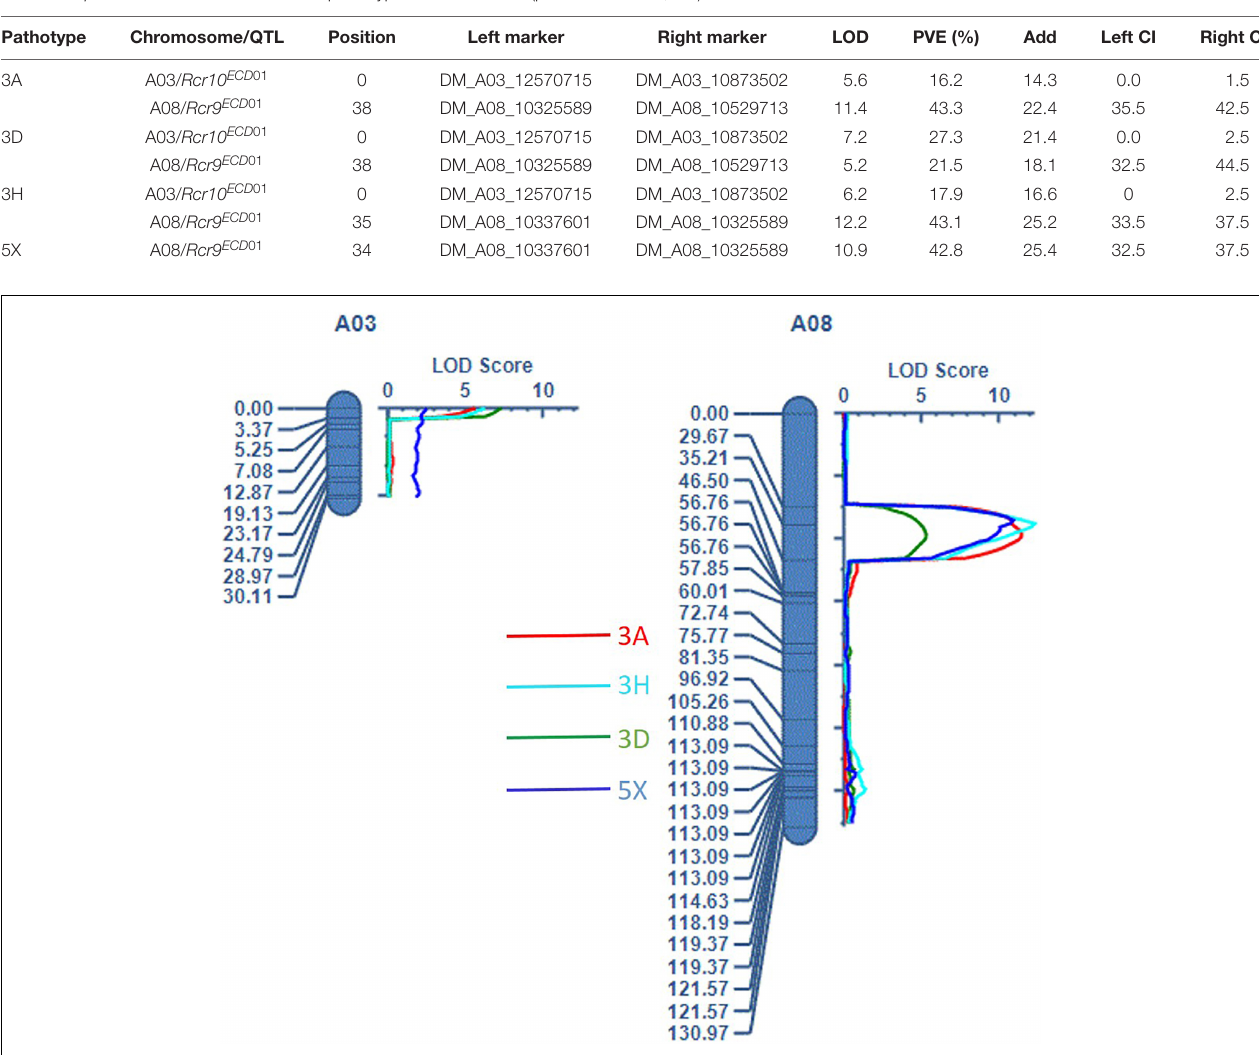
TABLE 3 | QTL position, phenotypic variation explained (PVE), additive (Add), the logarithm of the odds (LOD), and confidence interval (CI) for the QTLs originating from Brassica rapa ECD01 for resistance to four pathotypes of P. brassicae (permutations = 1,000). Pathotype Chromosome/QTL Position